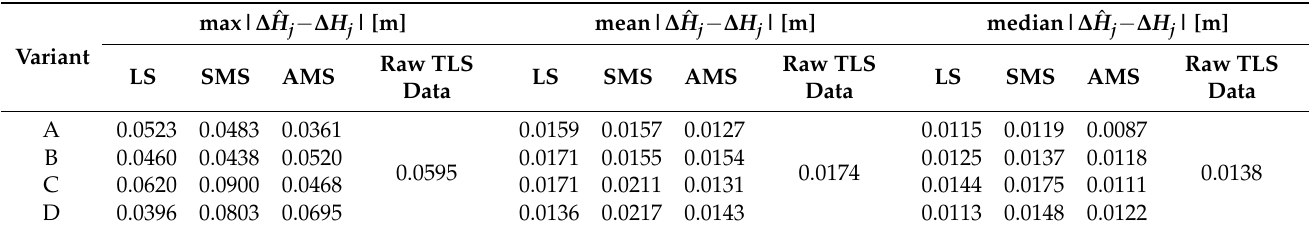
(cid:12) (cid:12) ∆ ˆ H (cid:12) (cid:12) − ∆ H j j (cid:12) (cid:12) between the terrain points of lines III and IV. H H between the terrain points of lines III and IV. j j